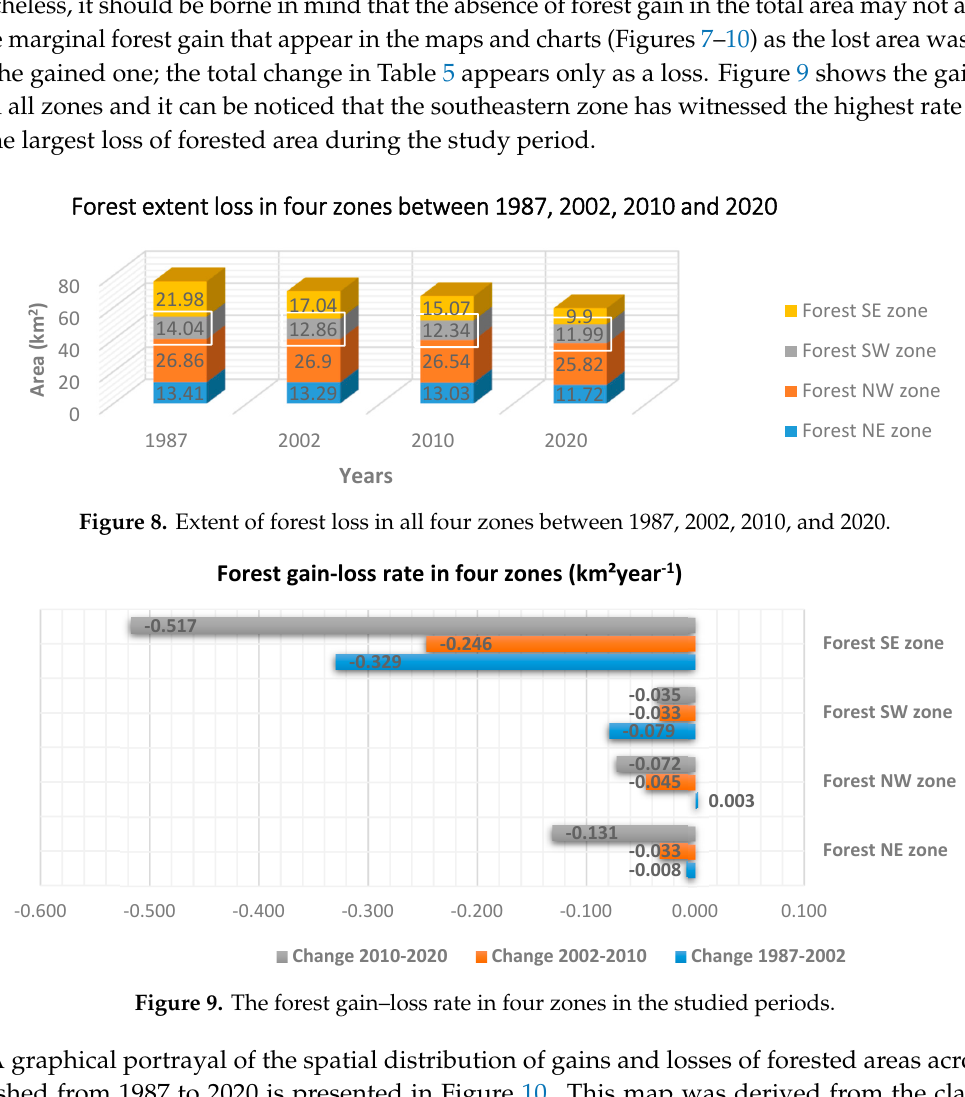
Figure 9. The forest gain–loss rate in four zones in the studied periods.